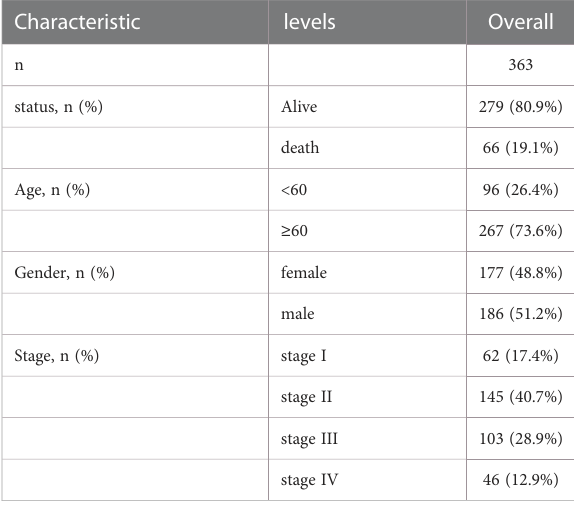
TABLE 1 Baseline data table of patients in TCGA-COAD dataset.